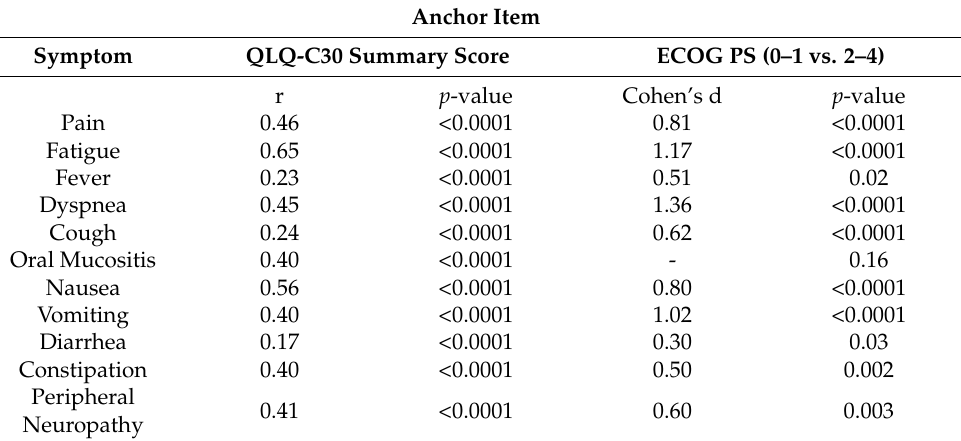
Table 2. Symptom item severity associations with QLQ-C30 scores and ECOG performance status (construct validity). (Abbreviations: ECOG PS-Eastern Cooperative Oncology Group performance status, QLQ-C30-European Organisation for Research and Treatment of Cancer Core Quality of Life Questionnaire, version 3.0).